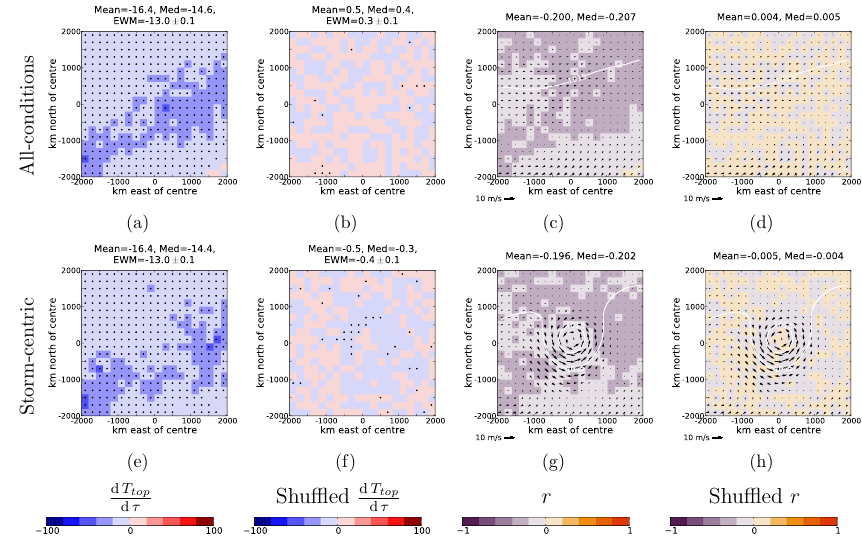
Figure 5: Fig. 5. Similar to Fig. 3, but for ordinary least squares regression fits of cloud top temperature ( T top , K) versus aerosol optical depth ( τ ) over the North Atlantic ocean. Table 3. Similar to Table 2, but for ordinary least squares regression fits of cloud top temperature ( T top , K) versus aerosol optical depth ( τ ) over the North Atlantic